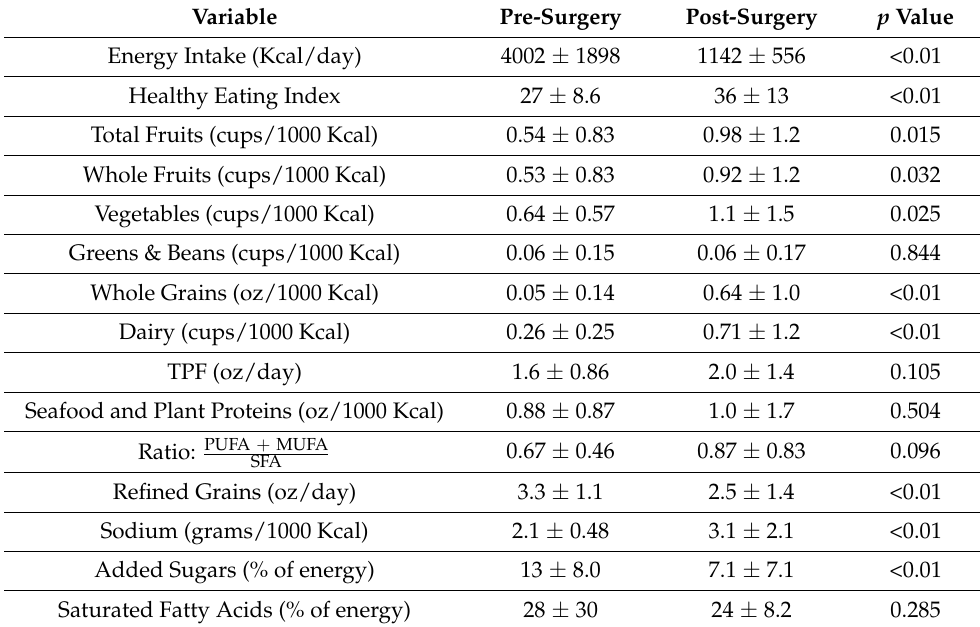
Table 2. Healthy index score components prior to and after bariatric surgery (mean ± SD).